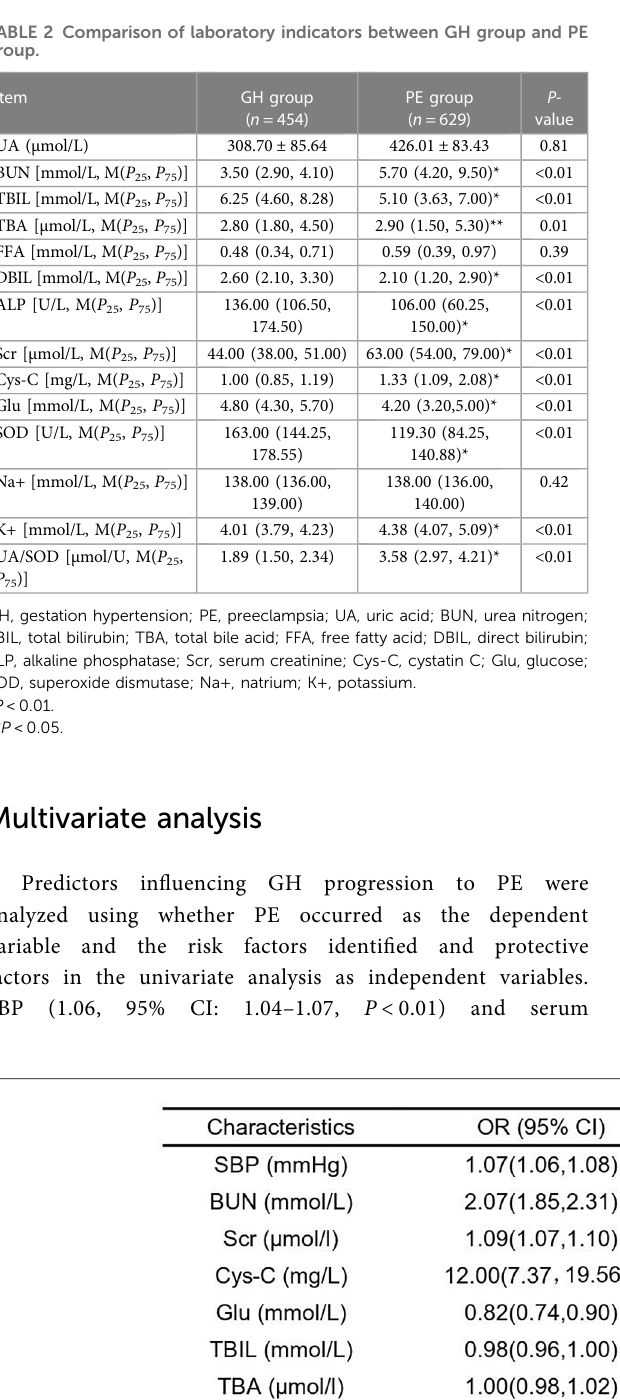
TABLE 2 Comparison of laboratory indicators between GH group and PE group.